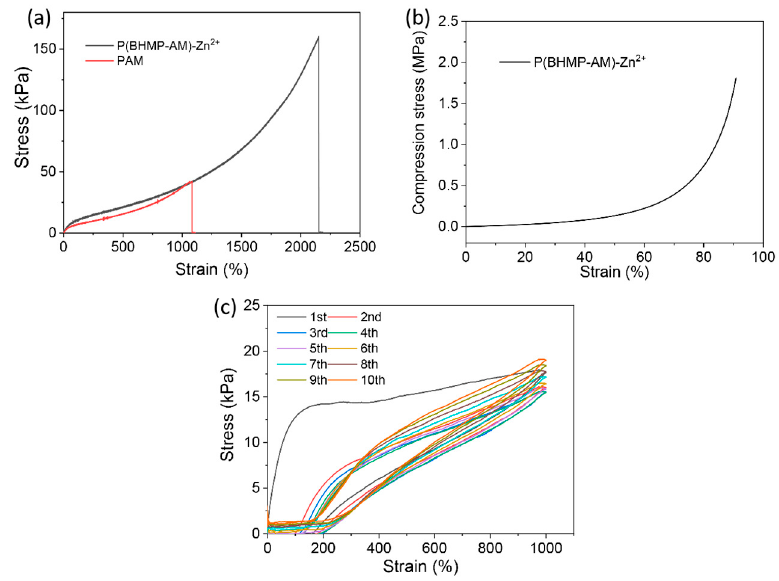
Figure 4. ( a ) Tensile stress–strain curves of the PAM and P(BHMP-AM)-Zn 2+ hydrogels. ( b ) Com- pression stress–strain curve of the P(BHMP-AM)-Zn 2+ hydrogel. ( c ) Loading/unloading stress–strain curve of the P(BHMP-AM)-Zn 2+ hydrogel under 400% strain.